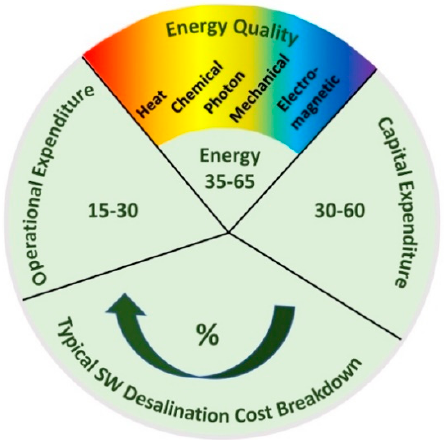
Figure 9. Typical seawater desalination cost breakdown and energy quality. Table 2. Input variables for the LCOW evaluation of MED and RO techniques .